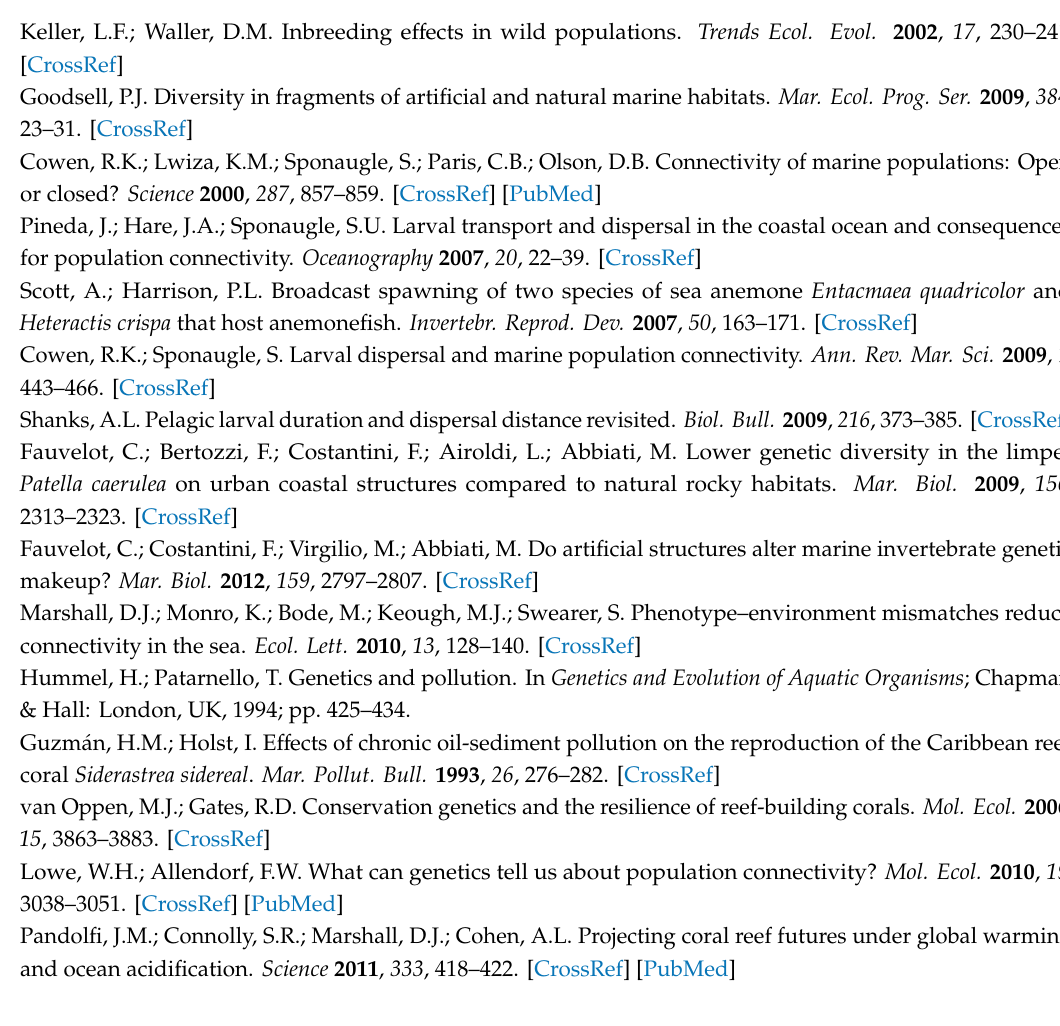
Figure S1: Cluster dendrogram of Stichodactyla haddoni , S. mertensii (STI134) and S. tapetum (STI102) based on the ITS1 barcodes. The numbers at each node indicates the percentage pairwise di ff erence. Figure S2: (a) Images of Heteractis magnifica and (b) Entacmaea quadricolor . Figure S3: BayeScan analysis outputs for (a) Stichodactyla haddoni and (b) Entacmaea quadricolor that were selected for downstream analyses, where FDR = 0.05. Dots labelled with numbers that fall to the right of the line are loci or SNPs identified as potential outliers. Figure S4: Histogram of pairwise genetic similarity for (a) sti_b1.10miss (b) ane_b3.10miss. ANE065-ANE088 pair (*) and the gap for potential clonemates (bracket) are indicated in (b). Figure S5: Outlier loci frequencies per site (a) sti_b1.10miss (b) ane_b3.10miss. Figure S6: (a) sti_b1.10miss lnPK graph, (b) sti_b1.10miss deltaK graph, (c) ane_b3.10miss lnPK graph, (d) ane_b3.10miss deltaK